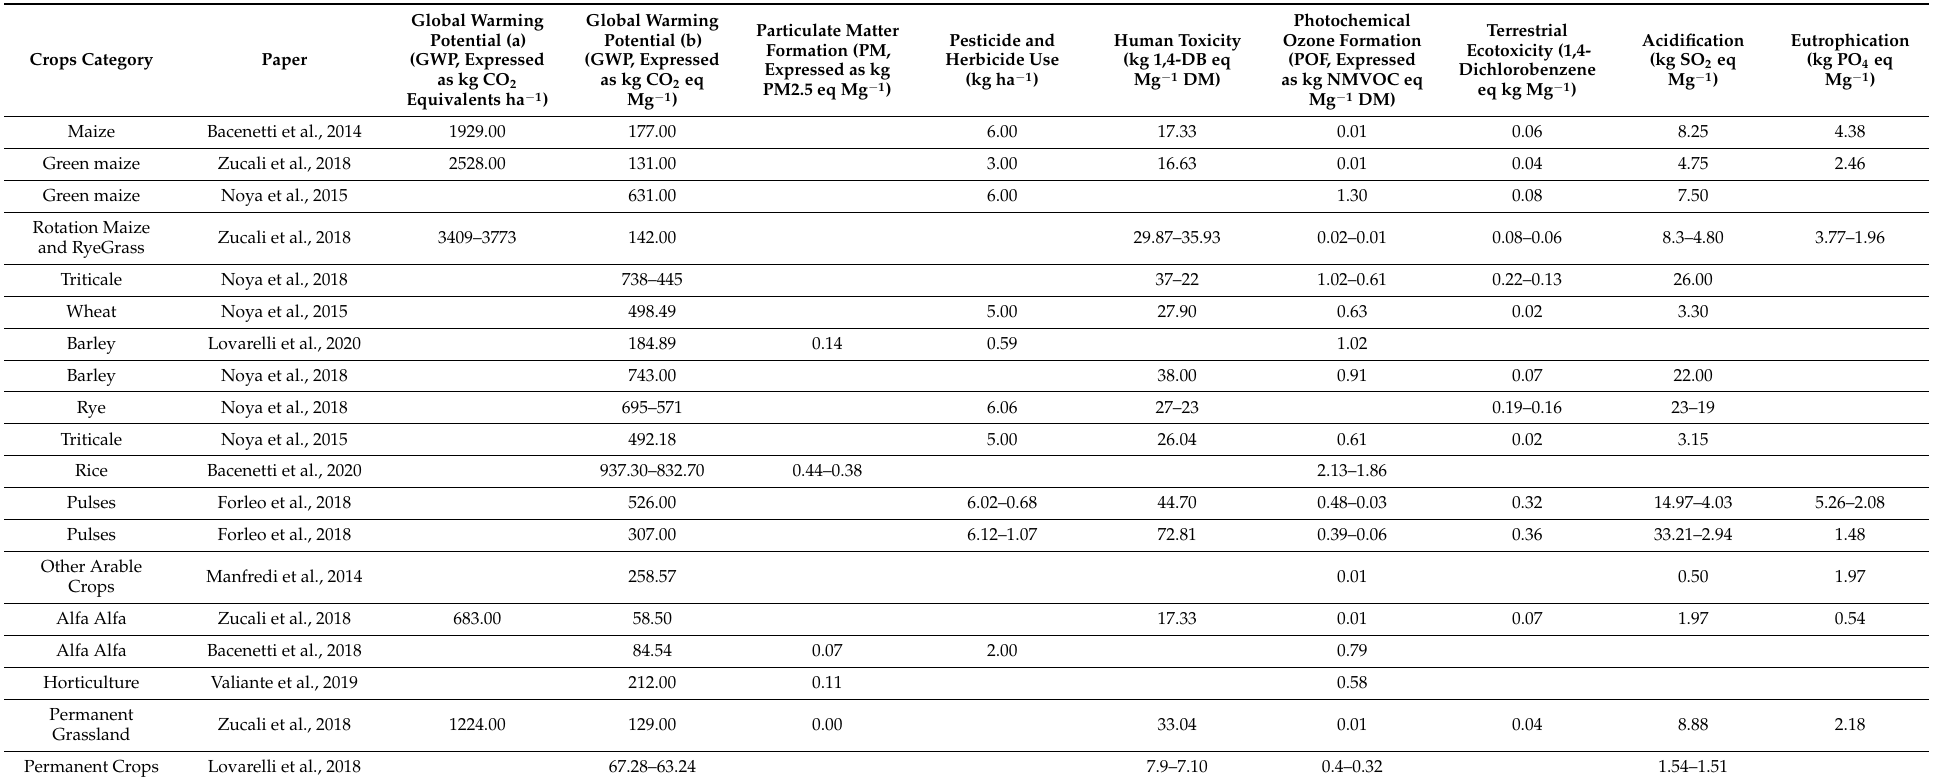
Table A2. Crops-related environmental indicators referred to Northern Italy